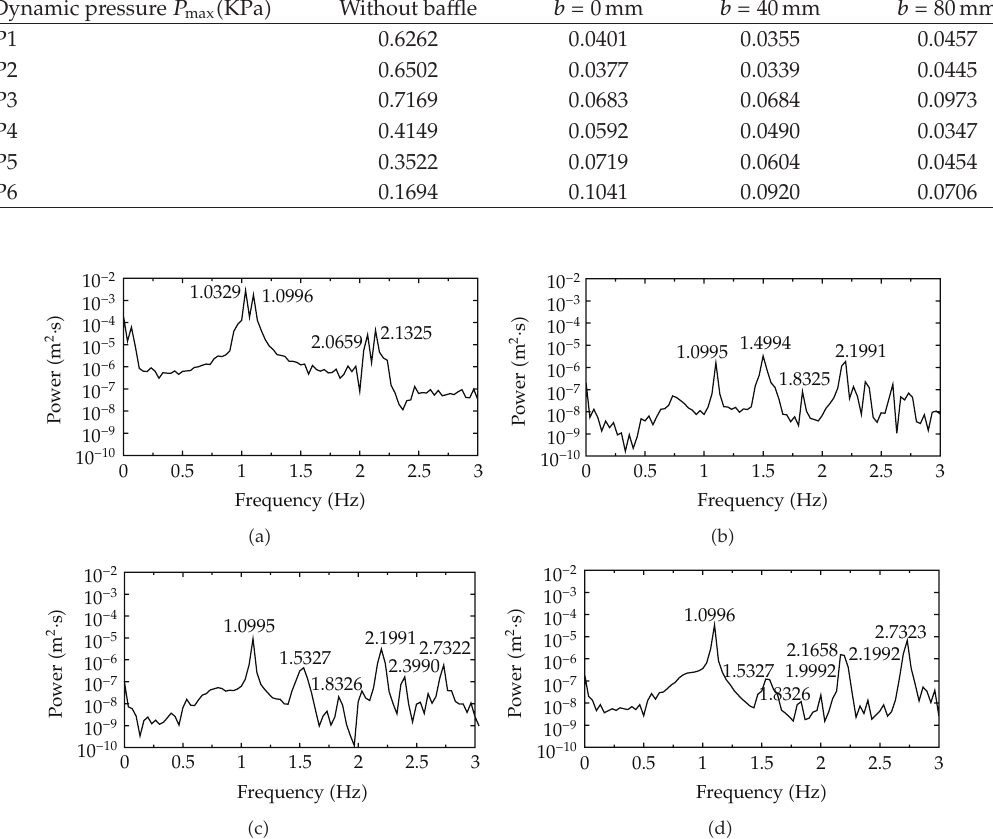
Figure 12: Power spectrum of the free surface elevation at wave gauge G 1 when the excitation frequency is ω (cid:9) 6 . 8636rad/s (cid:6)(cid:6) a (cid:7) without ba ffl e; (cid:6) b (cid:7) b (cid:9) 0mm; (cid:6) c (cid:7) b (cid:9) 40mm; (cid:6) d (cid:7) b (cid:9) 80mm (cid:7)